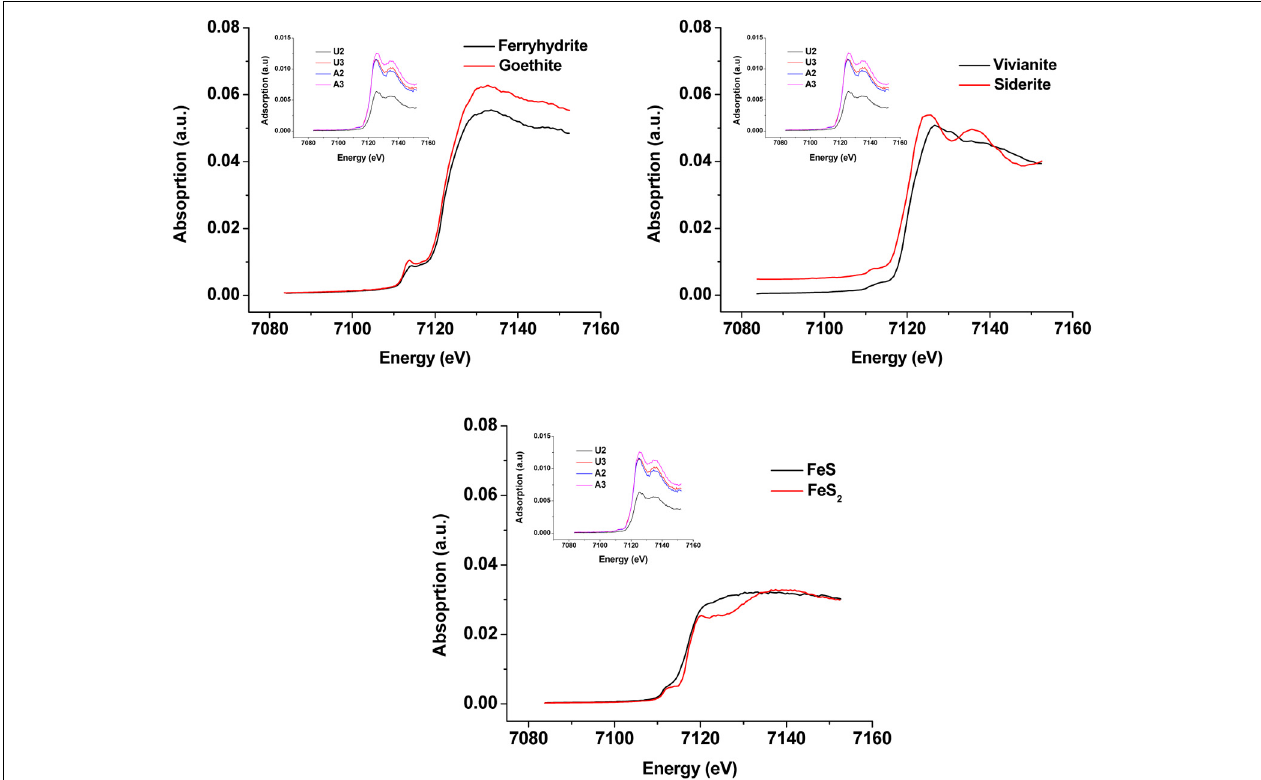
FIGURE 4 | X-ray Absorption Near Edge Structure (XANES) spectra of unamended and amended MFT from ports 2 and 3 after 213 days incubation (shown as inset in all panels) compared with K-edge XANES of dominant authentic Fe mineral standards (shown as main graphs).